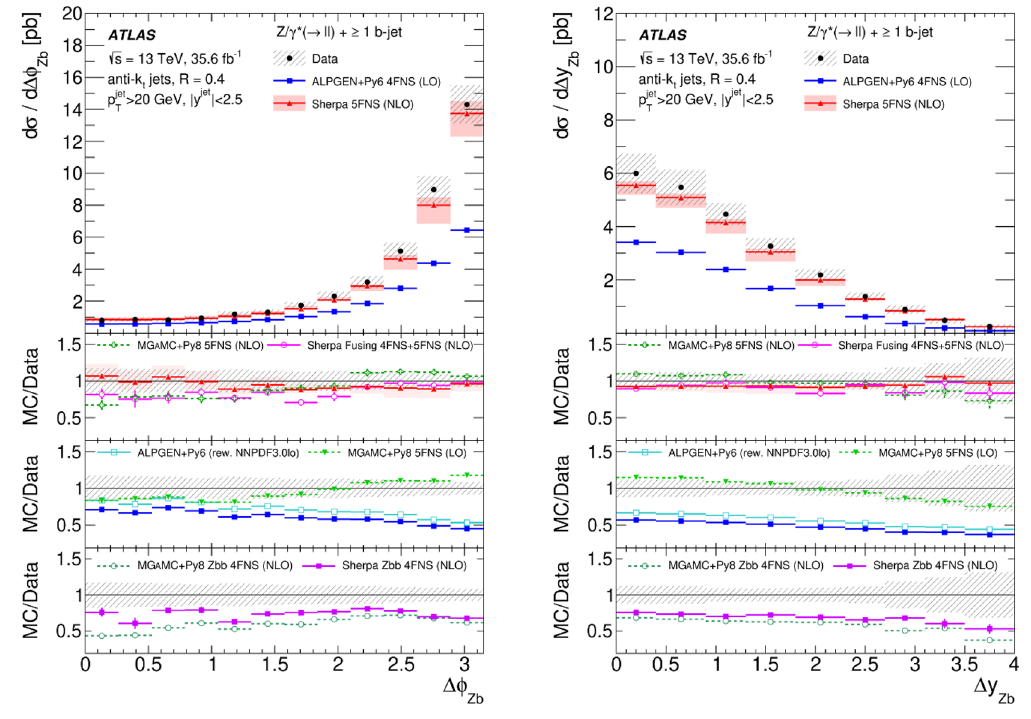
Figure 10 . Measured cross-section as a function of (cid:1) (cid:30) (left) and (cid:1) y between the Z -boson candidate and the leading b -jet (right) in events with at least one b -jet. The data are compared with the predictions from Sherpa 5FNS (NLO) , Alpgen + Py6 4 FNS (LO) , Sherpa Fusing 4FNS+5FNS (NLO) , Sherpa Zbb 4FNS (NLO) , MGaMC + Py8 5FNS (LO) , MGaMC + Py8 Zbb 4FNS (NLO) and MGaMC + Py8 5FNS (NLO) . The error bars correspond to the statistical uncertainty, and the hatched bands to the data statistical and systematic uncertainties added in quadrature. The red band corresponds to the statistical and theoretical uncertainties of Sherpa 5FNS (NLO) added in quadrature. Only statistical uncertainties are shown for the other predictions.